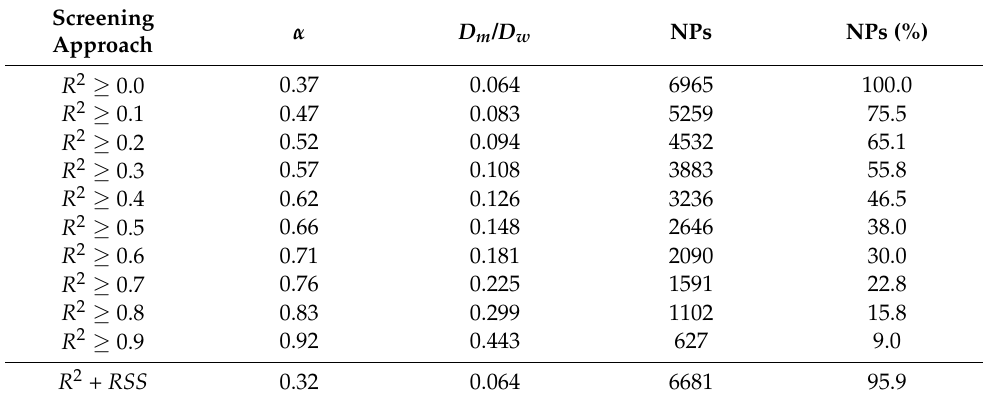
Table 1. Main results of particle tracking experiments performed for digested lipid nanocarriers obtained after following different approaches for the screening of trajectories showing poor goodness-of-fit. Screening